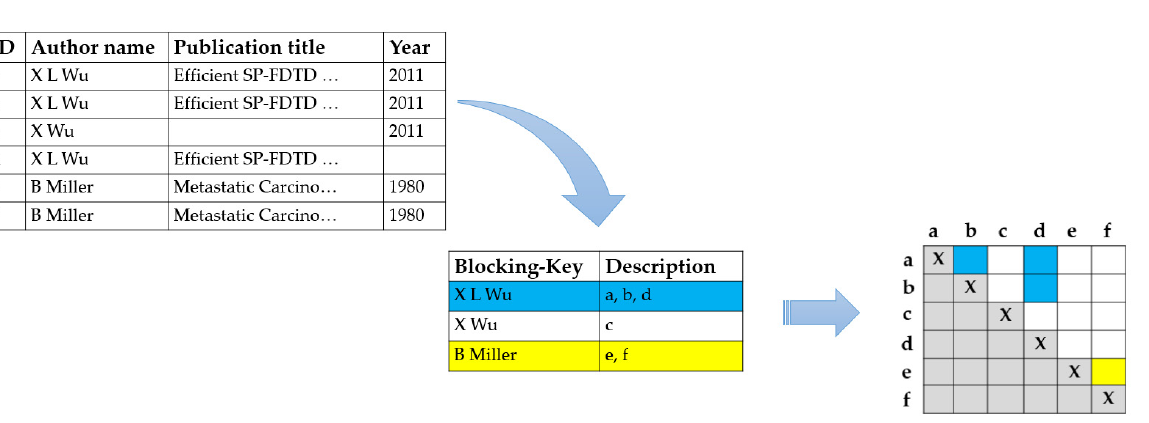
Figure 3. Standard blocking